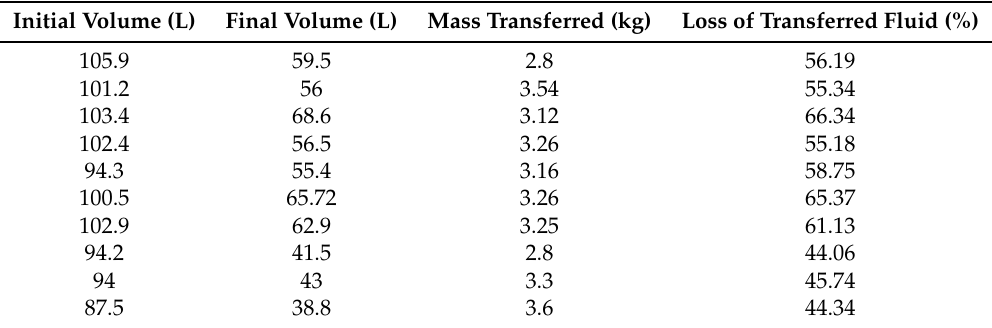
Table 3. Loss of helium when transferring liquid helium from 100 L helium tank to a 25 L helium tank (own analysis, based on experimental data, which shows the difference between liquid helium transferred from a 100 L helium tank (T = 4.2 K) to a 25 L helium tank).